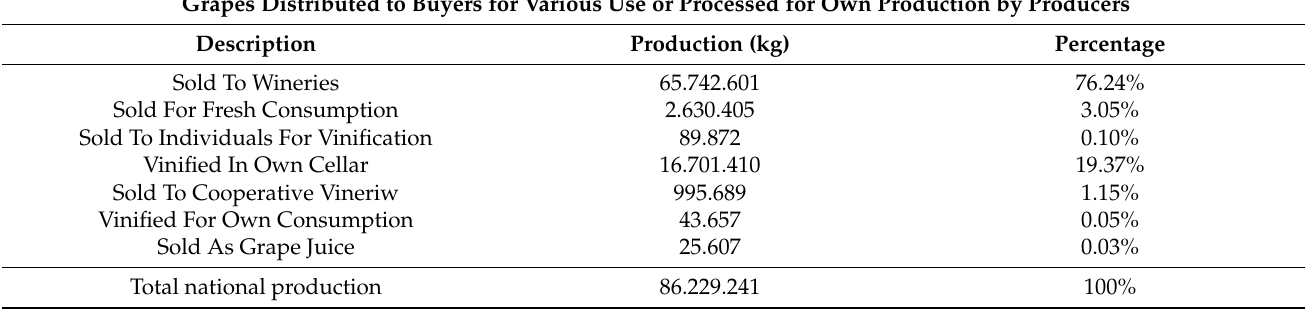
Table 7. End process and destination of harvested